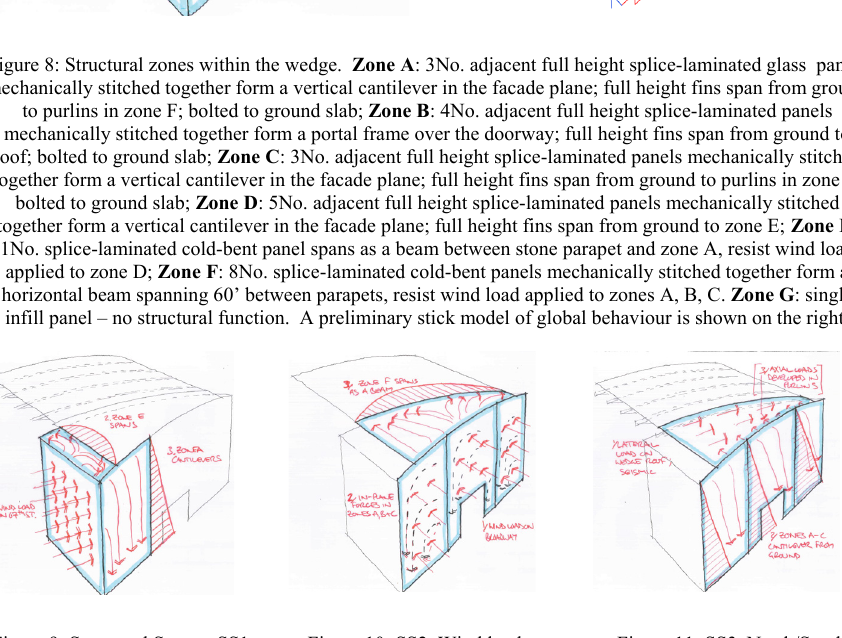
Figure 9: Structural System SS1, Wind load on 67 th St. façade.